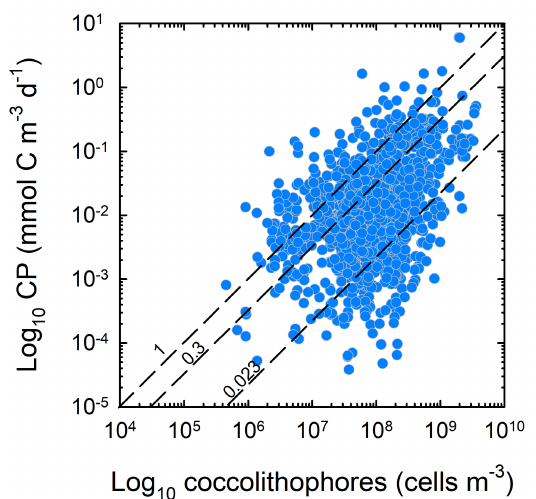
Figure 8. Scatterplot of log-normalised coccolithophore cell abun- dances and CaCO 3 production (CP) for all samples with matched count and rate data. Dashed lines indicate representative lines of cell-specific calcification (see Sect.